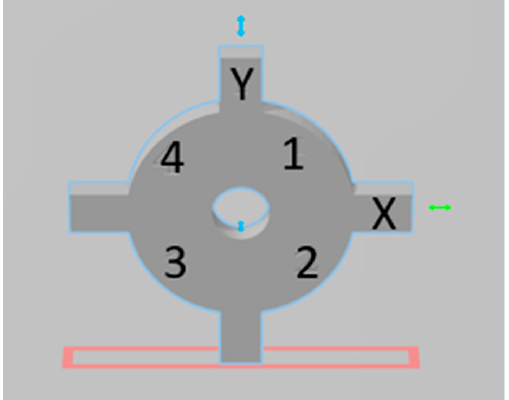
Figure 5. The final design of the calibration coupon with letters “X” and “Y” and numbers “1” through “4” engraved on the coupon (Meshmixer software, Autodesk, San Rafael, CA) to allow for orientation and measurement of the coupons.